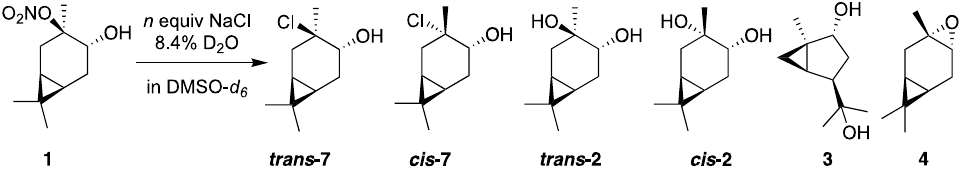
Figure 4. Product formation from the reaction of CHN 1 with Cl - in 8.4% D 2 O/DMSO- d 6 . Table 4. Product yields from the conversion of CHN 1 with varying equivalents of NaCl in 8% D 2 O/DMSO- d 6 . Yields are reported as averages and standard deviations obtained from triplicate measurements. n Molar Equiv. Entry